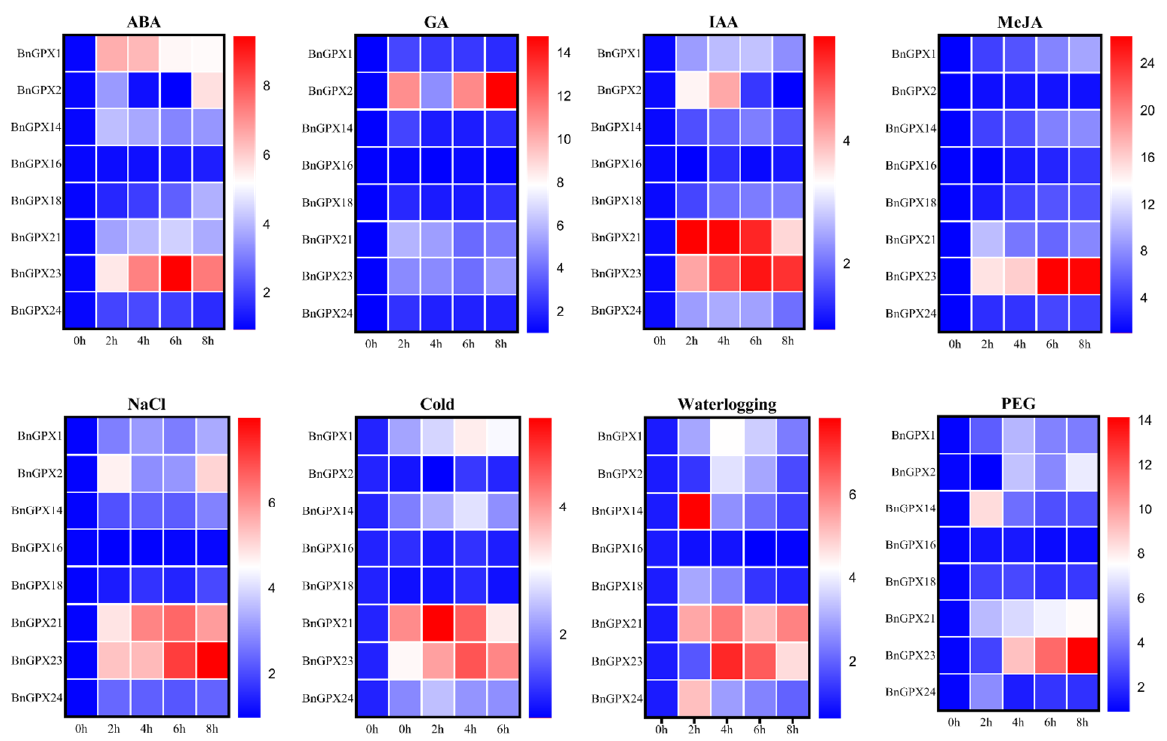
Figure 8. Expression profiles of BnGPX genes expression against various hormone and abiotic stress conditions at different time points (0 (CK), 2, 4, 6, and 8 h). The red color shows high and the blue color shows low expression levels. The expression bars present the comparative gene expressions based on the 2 −ΔΔCT method.